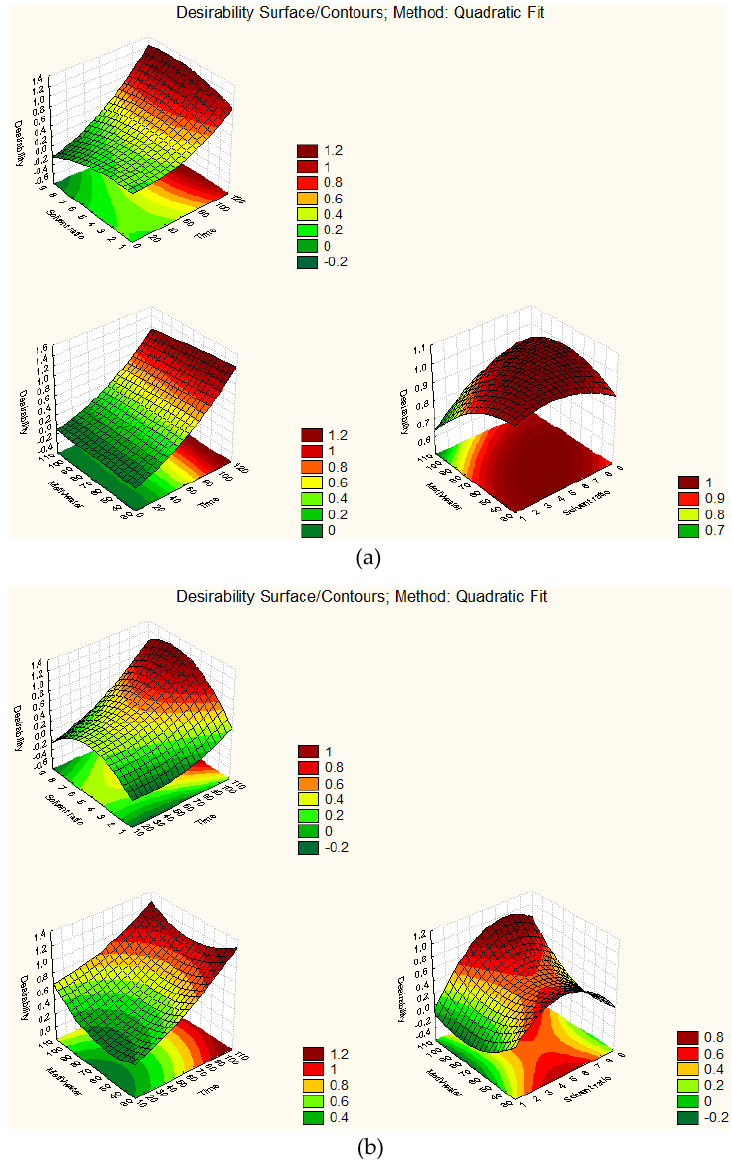
Figure 2. Desirability surface/contour plots ( a ) green leek leaf extracts; ( b ) white leek stem extracts.